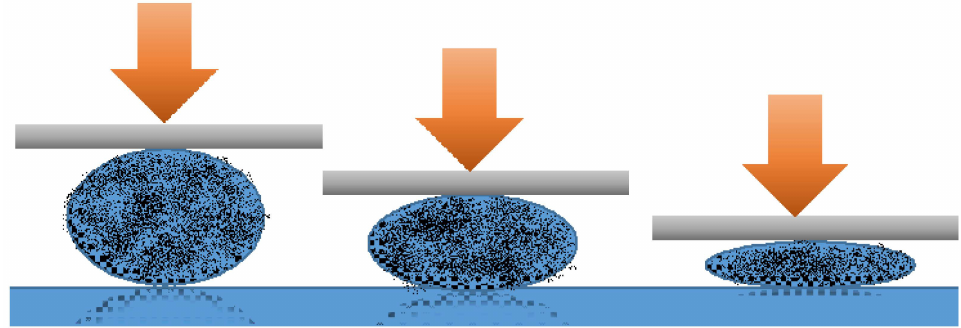
Figure 4. Liquid marble’s progressive deformation determined by increasing compression forces.